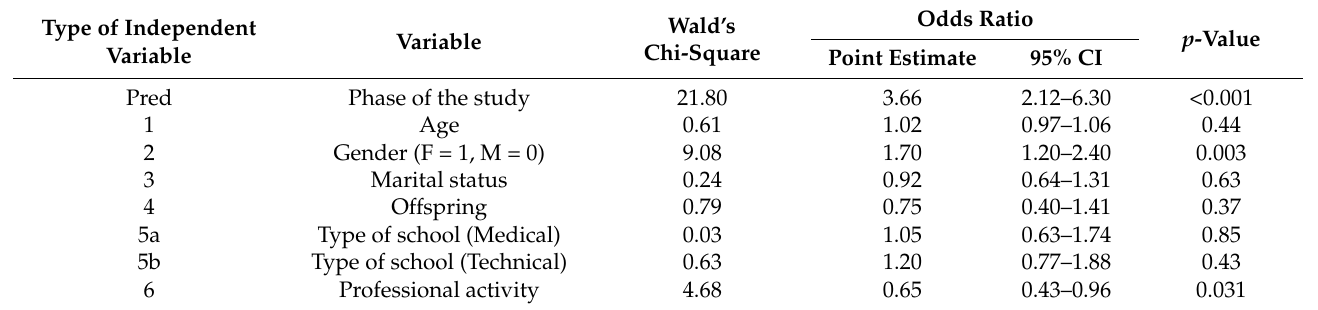
Table 3. Details of the adjusted logistic regression model evaluating the link of phase of the